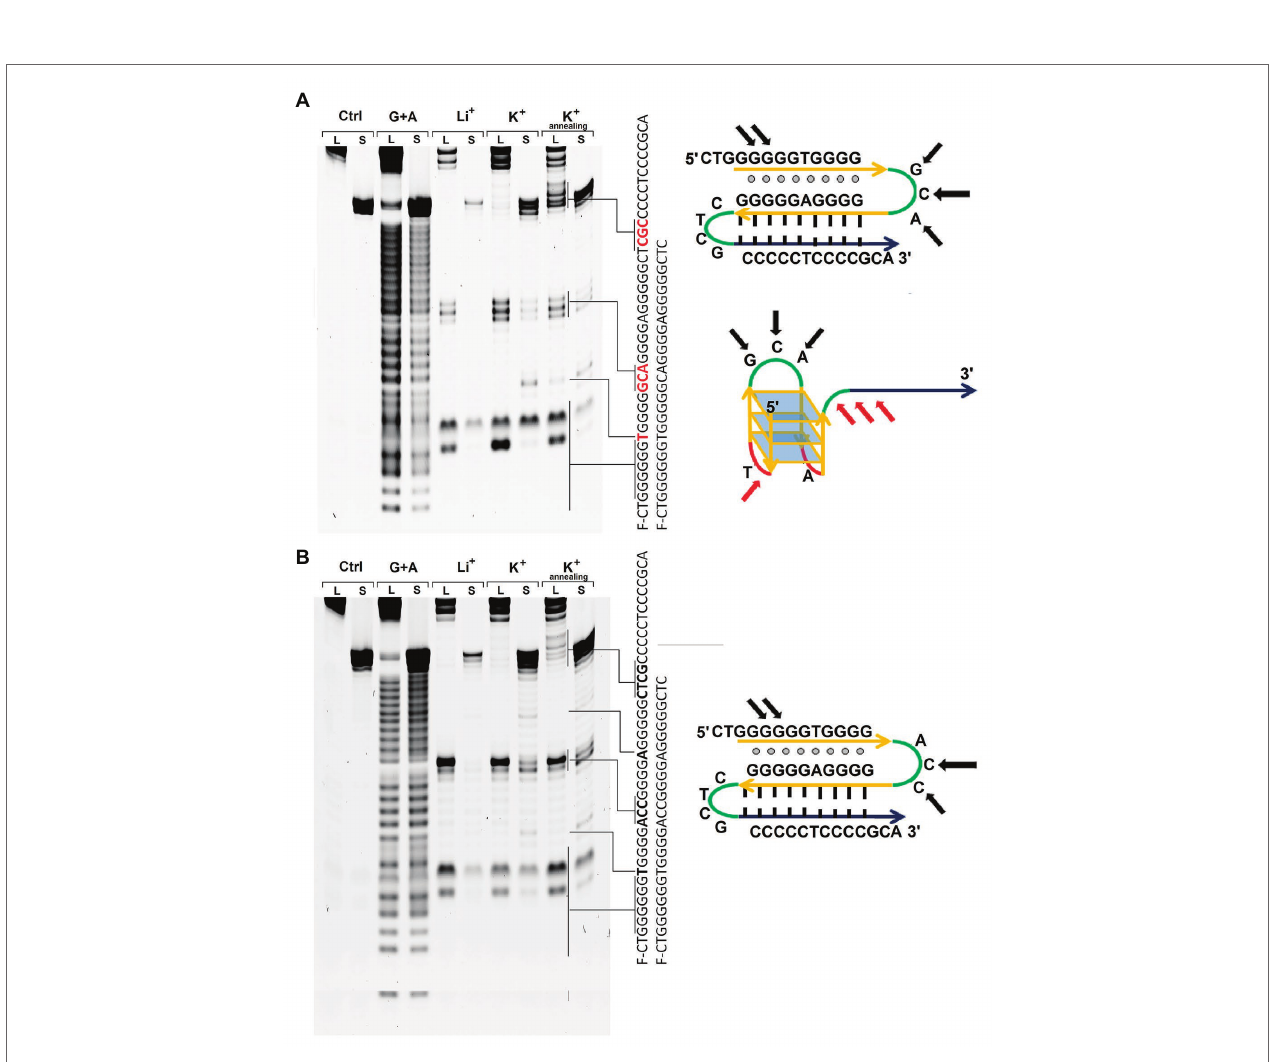
FIGURE 5 | S1 nuclease probing of the structures formed by ODNs GCA-S and GCA-L (A) and ODNs ACC-S and ACC-L (B) in the presence of Li + ions or K + ions before and after renaturation. L – longer ODNs ACC-L or GCA-L, S – shorter ODNs GCA-S or ACC-S. Sequencing G+A lane was performed by treatment of the ODNs with formic acid. On the right – schematic depictions of the alternative structures that the longer ODNs GCA-L or ACC-L may adopt the intramolecular triplex and G4 folding. Black arrows indicate the S1 cleavage regions common for structures regardless solution conditions; red arrows show the bands that appear after renaturation of the long ODNs in presence of potassium